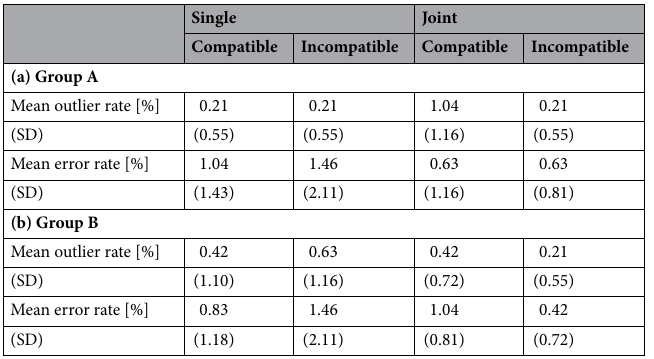
Table 1. Mean outlier and error rates in the Single and Joint conditions for (a) Group A (diotic sound) and (b) Group B (binaural sound), Experiment 1. Significant main effects or interactions are not observed.